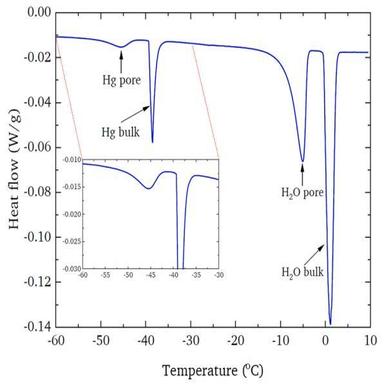
DSC melting curve for both mercury and water within the same sample of G1 following entrapment during porosimetry and immersion in water.